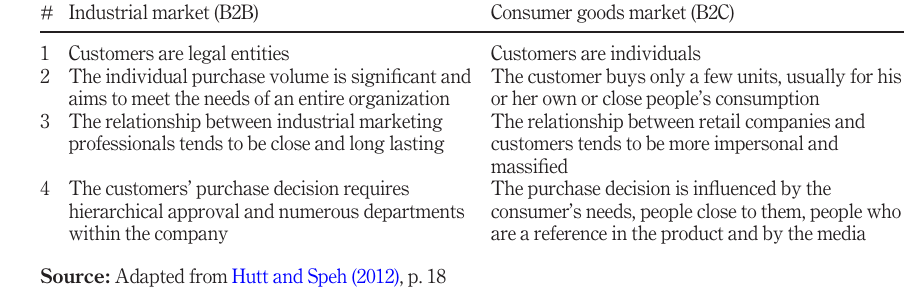
Table I. Characteristics of customers and consumers in the B2B and